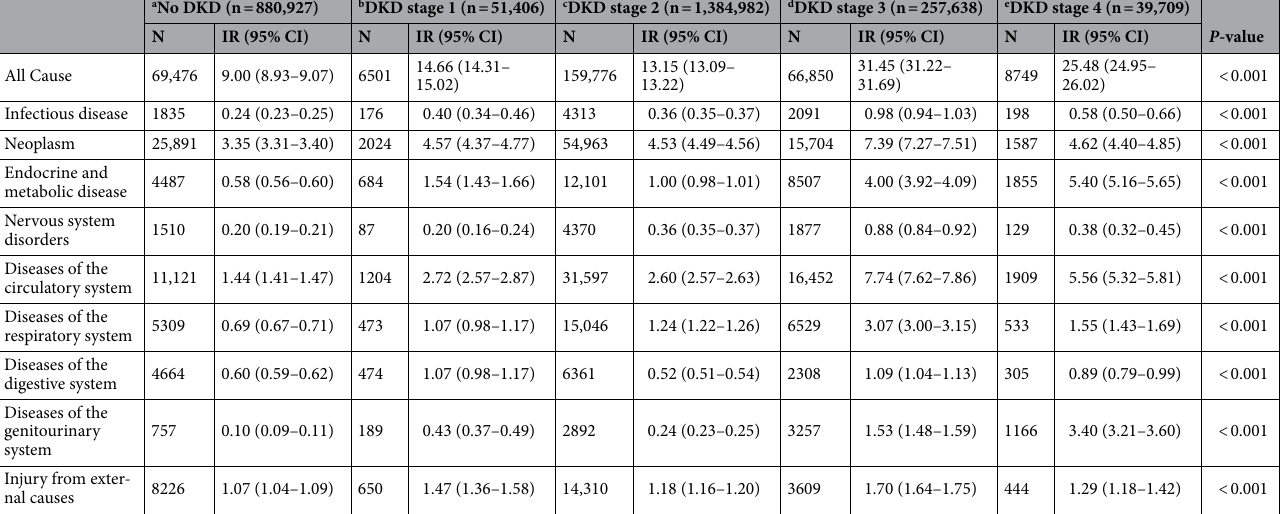
Table 2. Incidence rates of causes of death according to DKD stage. * IR incidence rate per 1000 person-years. a No DKD: eGFR ≥ 90 mL/min/1.73m 2 , negative or trace in dipstick proteinuria, b DKD stage 1: eGFR ≥ 90 mL/ min/1.73m 2 , ≥ 1 + in dipstick proteinuria, c DKD stage 2: 60 mL/min/1.73m 2 ≤ eGFR < 90 mL/min/1.73m 2 ,